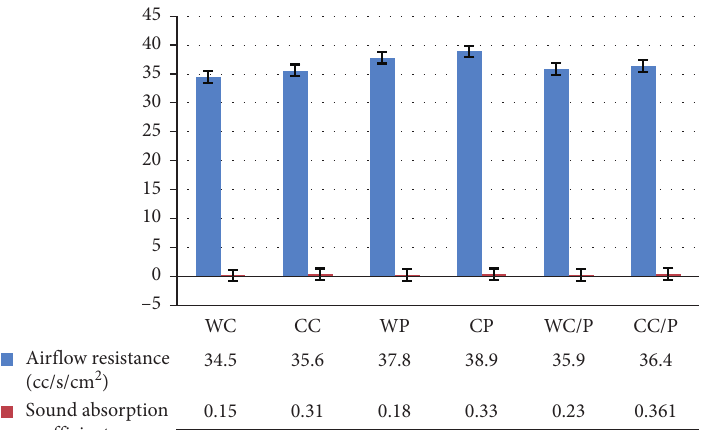
Figure 9: Influence of airflow resistance on sound absorption coefficient.